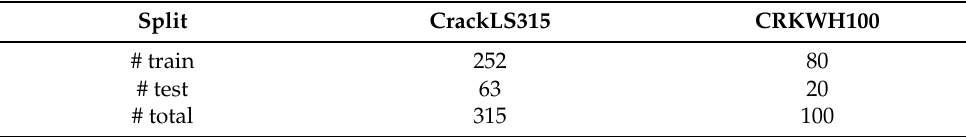
Table 1. The statistics of two benchmark Datasets .